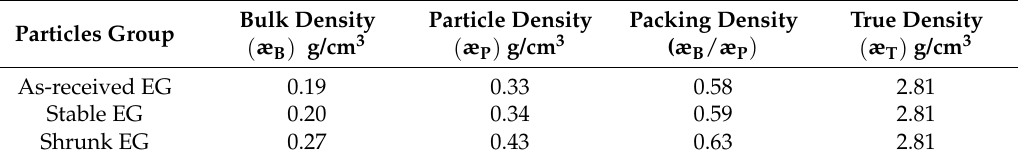
Table 1. EG particles